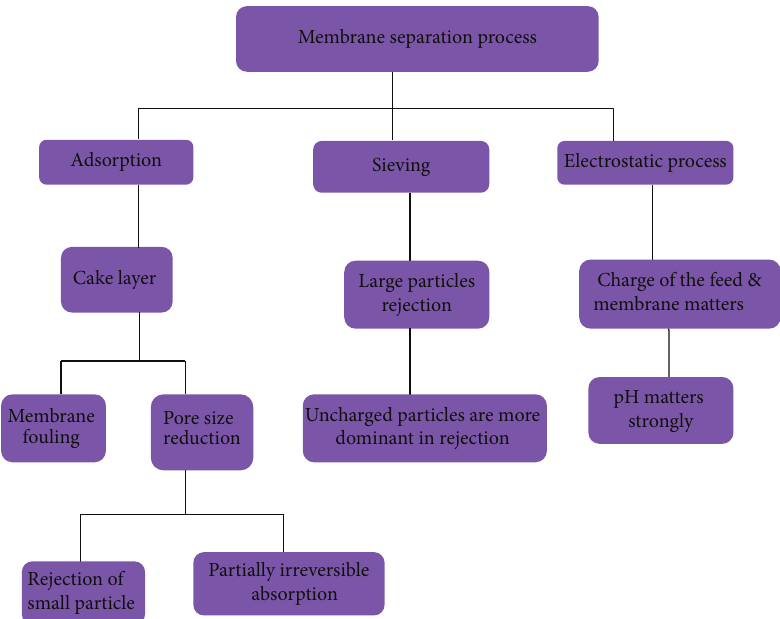
Figure 5: Schematic representing the basic principles involved in membrane separation